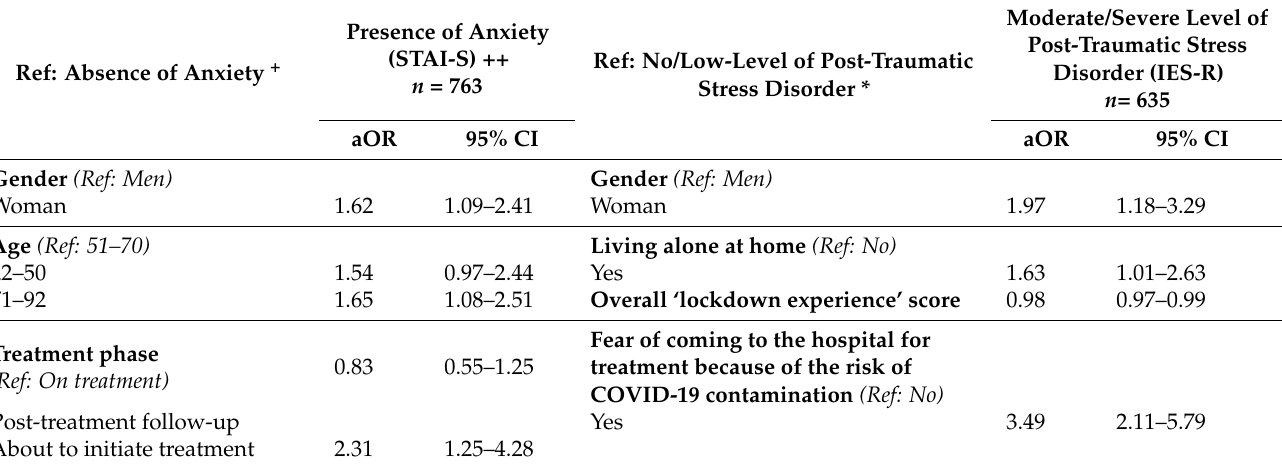
Table 2. Factors associated with anxiety level and post-traumatic stress disorder during the COVID-19 health crisis: multivariate